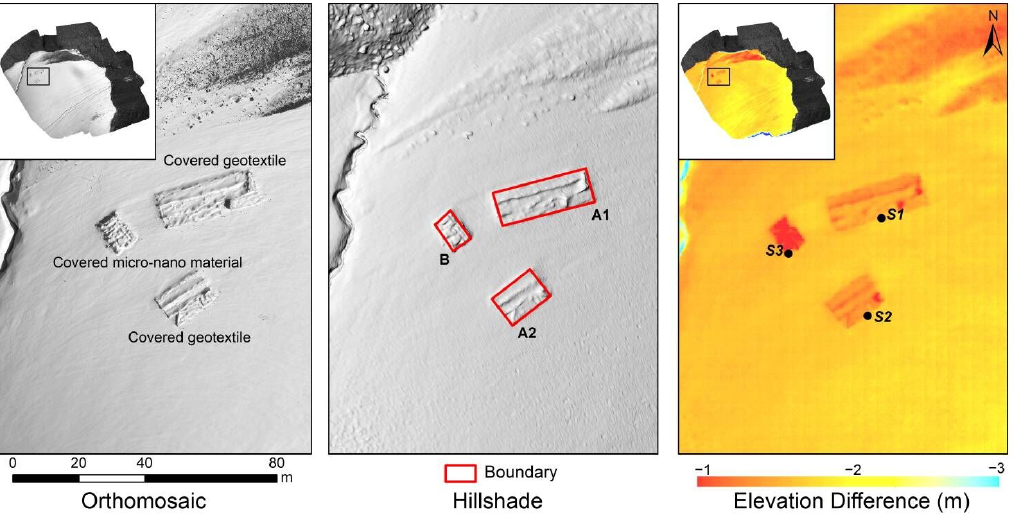
Figure 3. Ortho-mosaic on 28 August 2021 ( left panel), hillshade generated from the DEM on 28 August 2021 ( middle panel), and changes in elevation between 24 June and 28 August 2021 ( right panel). Glacier ablation was monitored using ablation stakes